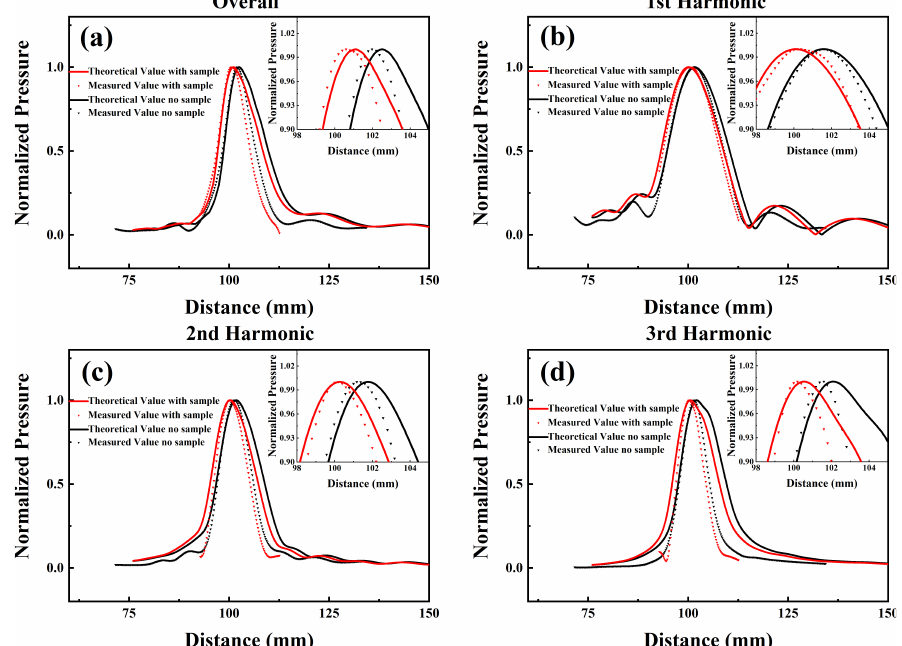
Figure 5. Comparison of the axial distributed acoustic pressure between the cases of with and without the phantom sample: ( a ) the overall pressure; ( b ) the fundamental component; ( c ) the second harmonic; ( d ) the third harmonic.